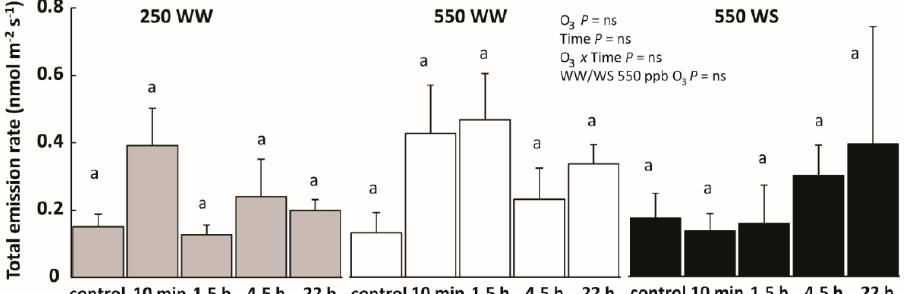
Figure 5. Total volatile emission rates (mean ± SE) in well-watered (WW) and water-stressed (WS) O 3 -fumigated B. nigra plants before exposure (control) and through the recovery phase (grey bars—WW/250 ppb O 3 ; white bars—WW/550 ppb O 3 ; black bars—WS/550 ppb O 3 ). The values between different time-points among treatments were compared by paired sample t-tests and significant differences ( p < 0.05) are indicated by lowercase letters. The effect of O 3 exposure, recovery time, their interaction and the effect of water stress (WS vs. WW) for plants treated with 550 ppb O 3 were evaluated by repeated measures ANOVA. ns denotes non-significant effects ( p > 0.05).